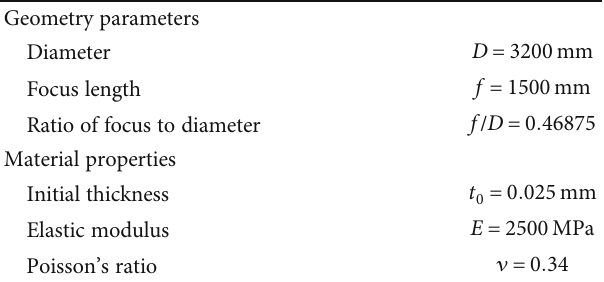
Table 1: Geometry parameters and material properties.